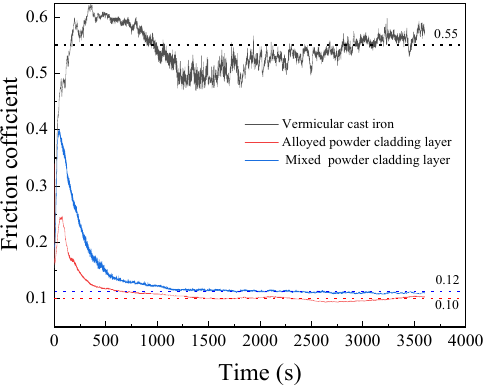
Figure 12. Friction coefficient of three tribo-pairs as a function of sliding time.